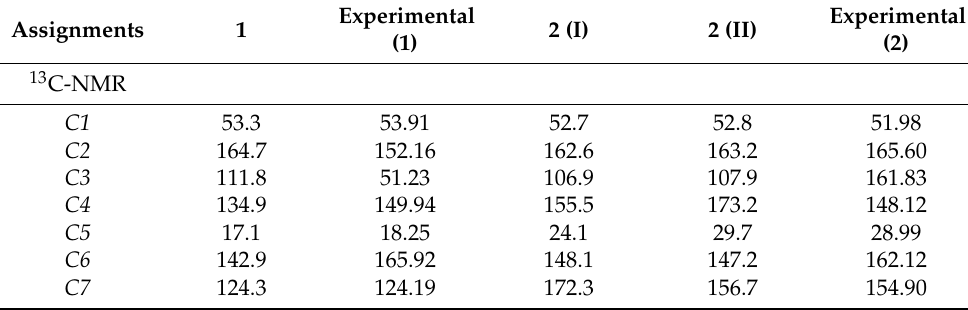
Table 7. Spectral data for the studied compounds, calculated at the B3LYP-D3/6-311++G(d,p) level and experimental